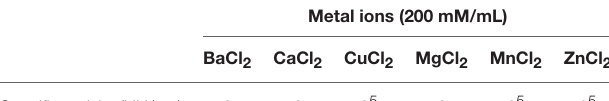
TABLE 3 | Effect of Metal Ions on hemagglutinating activity of Eutirucallin.